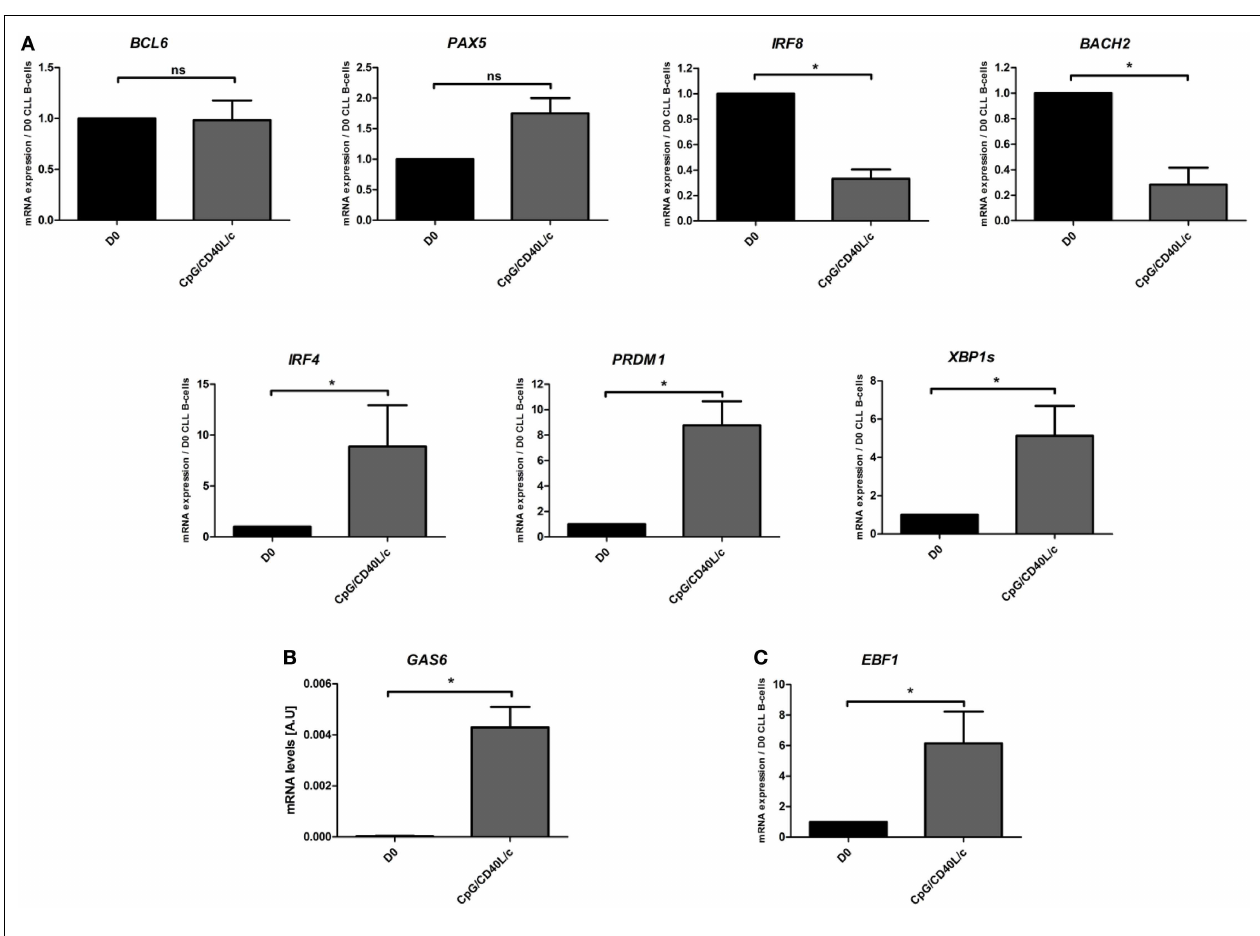
mean ± SEM from five experiments. (B) The relative mRNA expression of GAS6 in CLL B-cells on D0, compared with CpG/CD40L/c-stimulated cells on D7.The data were calculated according to the relative 2 – ∆ CT method.The values on D7 were compared with those on D0, and the statistical significance was calculated in aWilcoxon test: * p < 0.05. ns, not